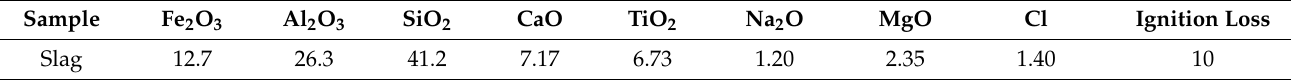
Table 1. XRF analysis results of waste incineration